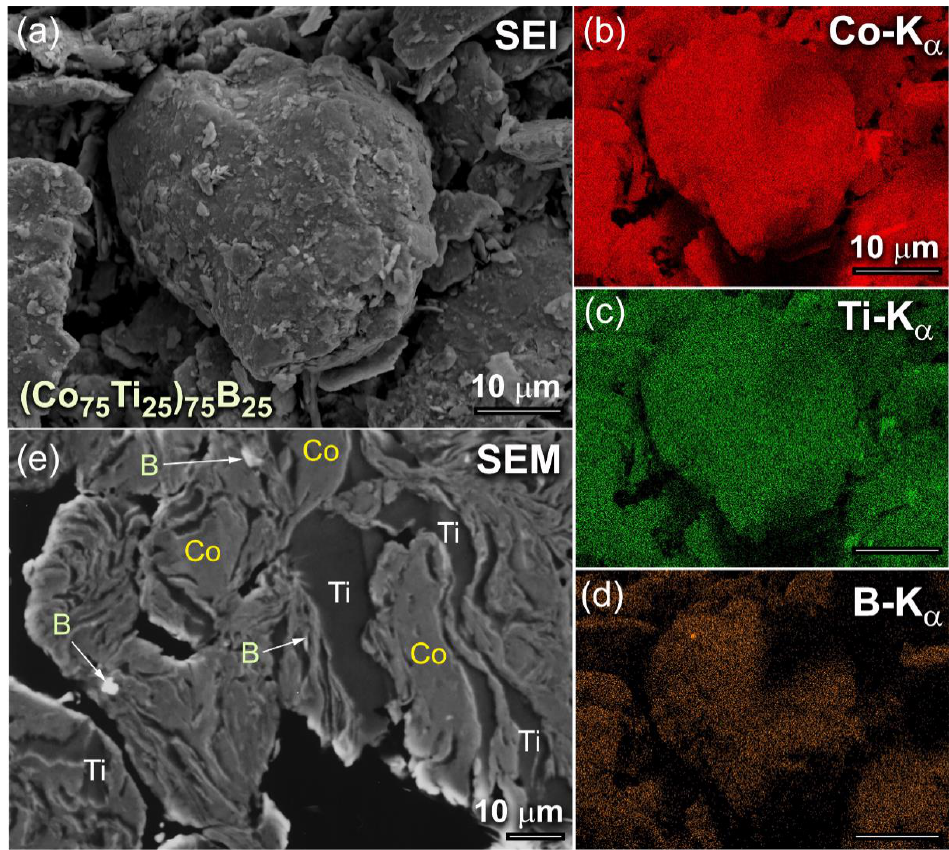
Figure 1. ( a ) Scanning electron image (SEI) of as-BM (Co 75 Ti 25 ) 75 B 25 powders obtained after 6 h of MA time. The corresponding EDS-elemental maps of Co, Ti, and B are displayed in ( b ), ( c ) and ( d ), respectively. The FE-SEM micrograph of the cross-sectional view for the powders after this stage of milling is presented in ( e ).